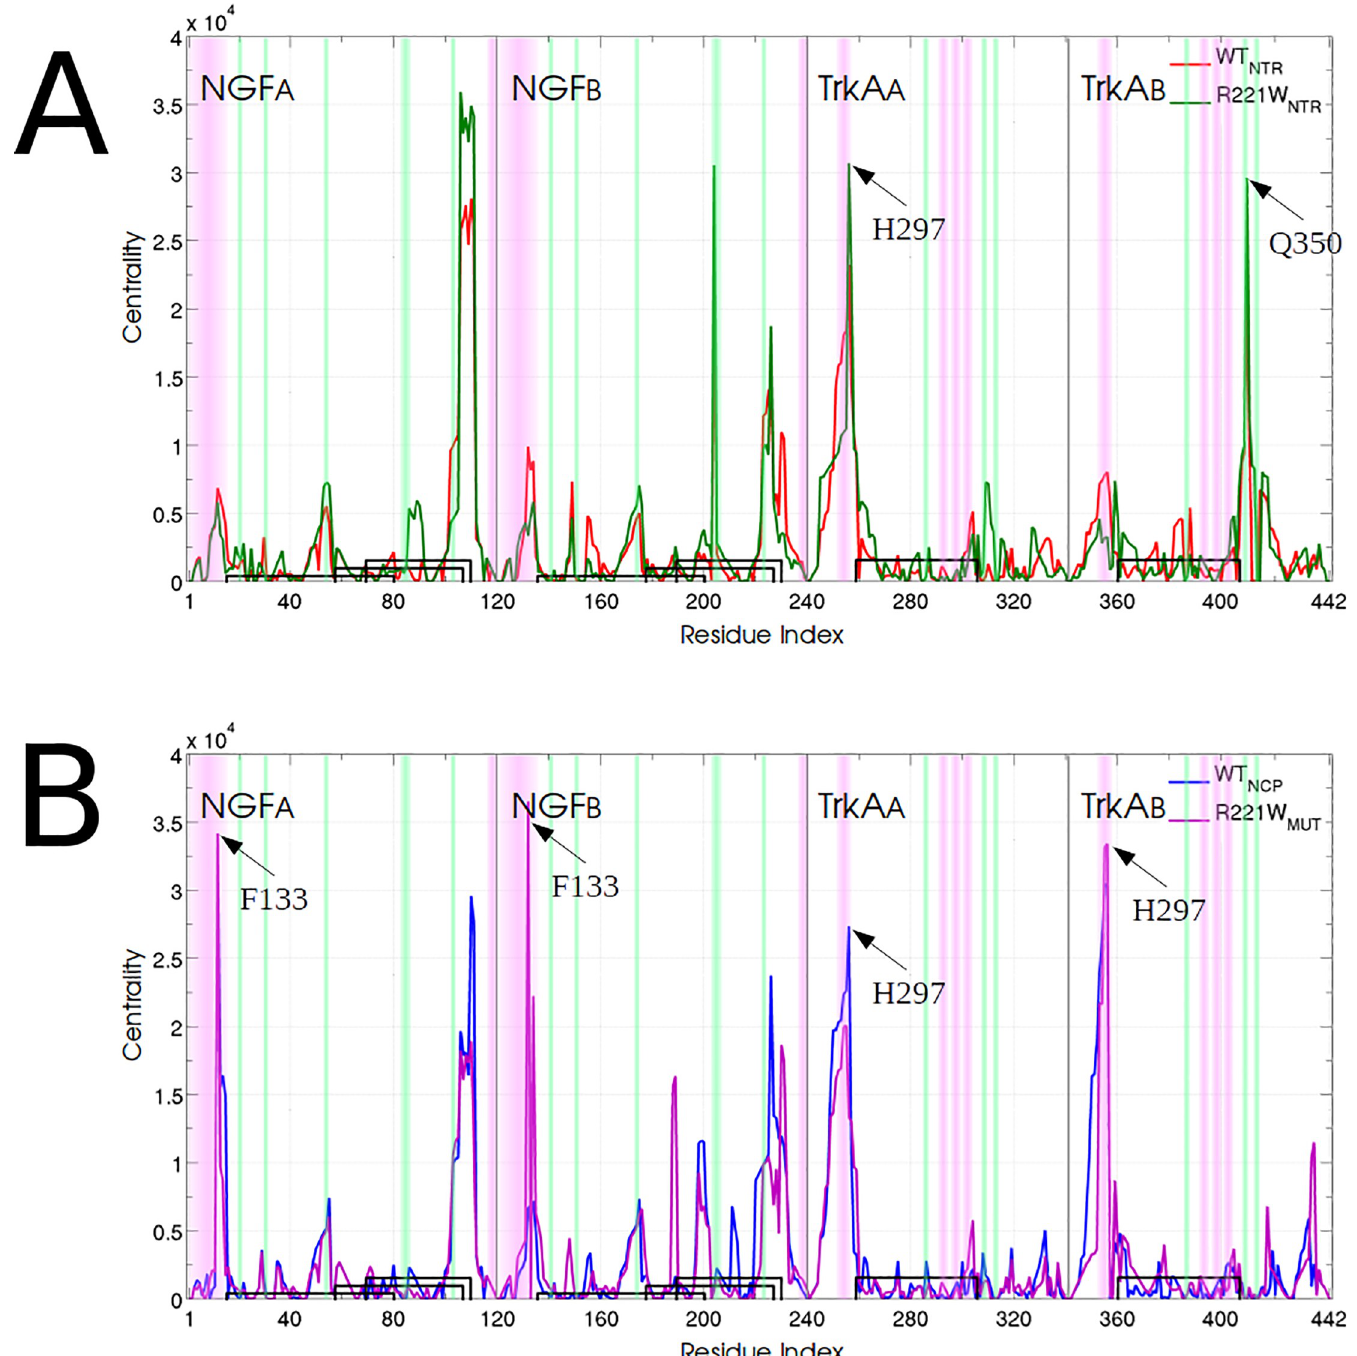
Fig 8. Differences in residue-wise centralities in dynamical networks. (A) Comparison between WT Q NTR and R221W Q NTR residue centralities indicates great similarity all along the complex. (B) Despite the similar centrality values for both TrkA chains, Q Purple and green stripes indicate specificity and conserved patch residues, respectively. Arrows indicates residues with high degeneracy in interface regions. Black connectors represent disulfide bonds.